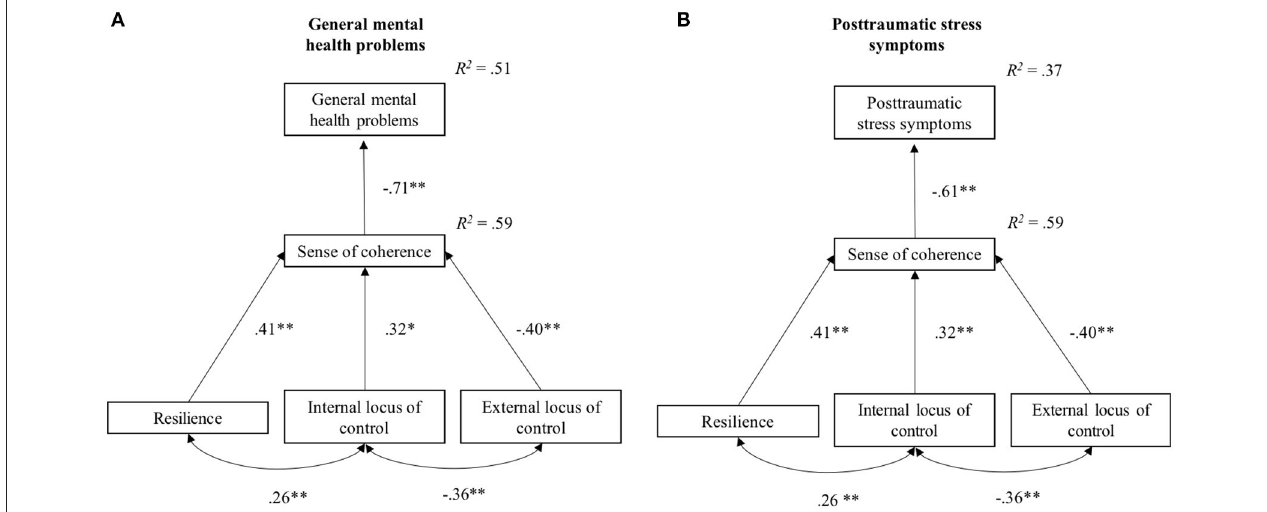
FIGURE 2 | Path models for general mental health problems (A) and post-traumatic stress symptoms (B) with standardized regression weights, correlations, and explained variances. * p < 0.05, ** p < 0.01.